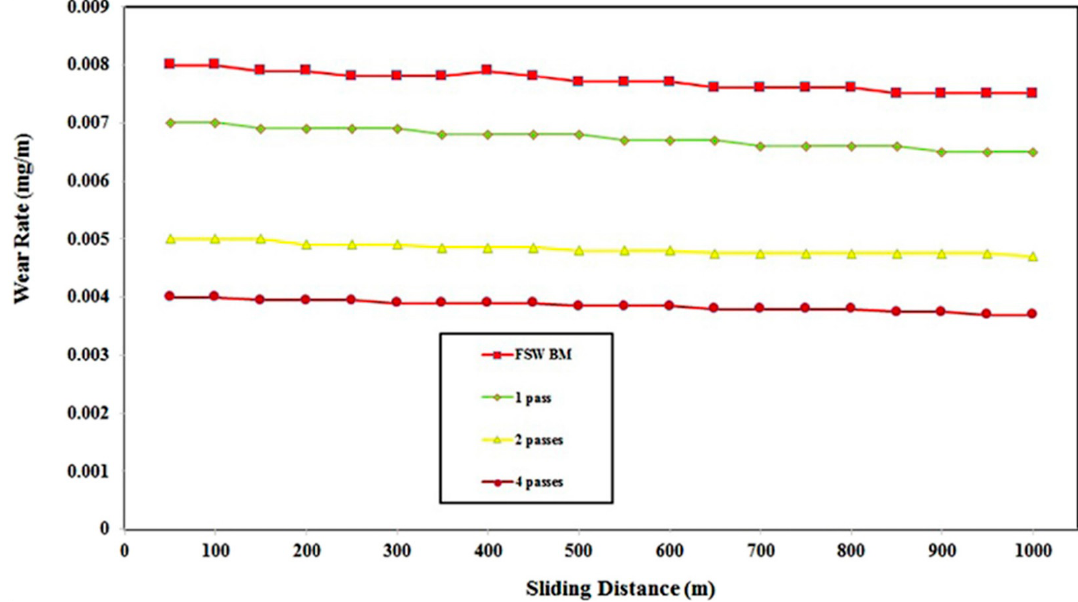
Figure 8. Wear rate of joints without and with TiO 2 nanoparticle reinforcement vs. sliding distance [52].